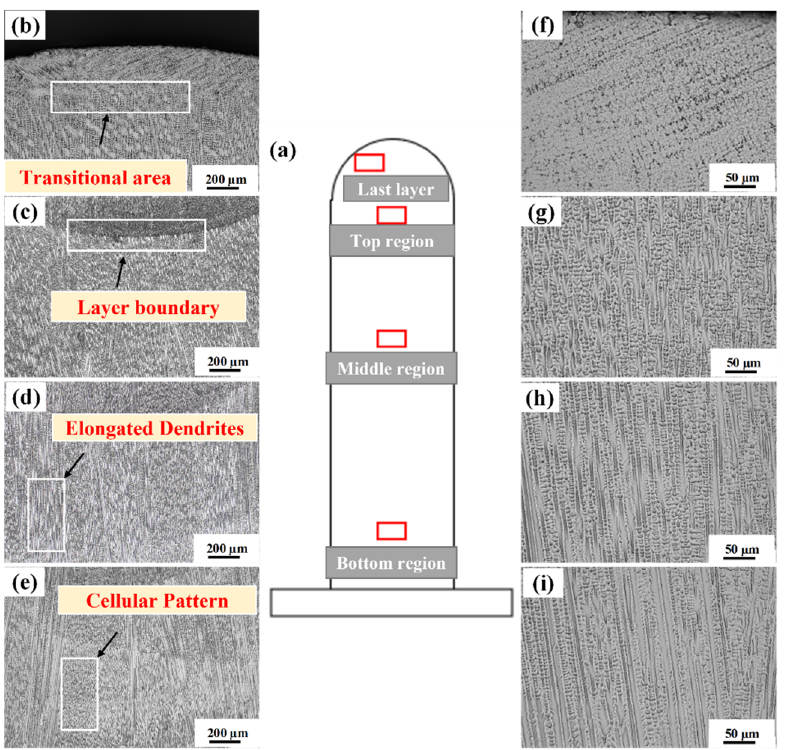
Figure 3. Microstructure morphology in cross-section (y–z plane) of the as-fabricated sample with heat input 276 J/mm. ( a ) Illustration of microstructure observing position; ( b – i ) are representative microstructure at low and high magnifications for different positions: ( b , f ) last layer, ( c , g ) top region, ( d , h ) middle region and ( e , i ) bottom region.